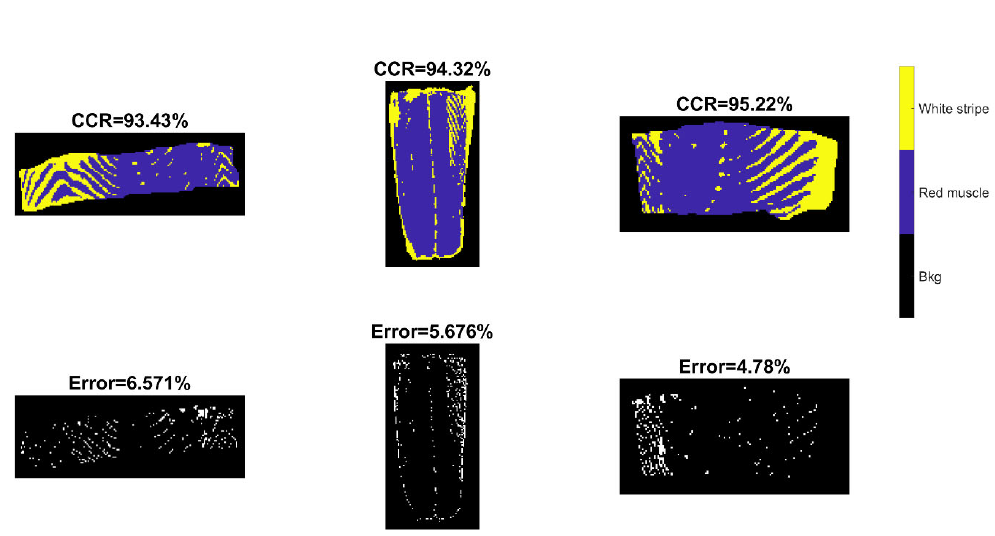
Figure 9. Classification and misclassification maps for validation (the left image) and test sets (the middle and right images) obtained by the support vector machine (SVM) model built from EPO pre ‐ treated spectra (SVM ‐ III of Table 2).